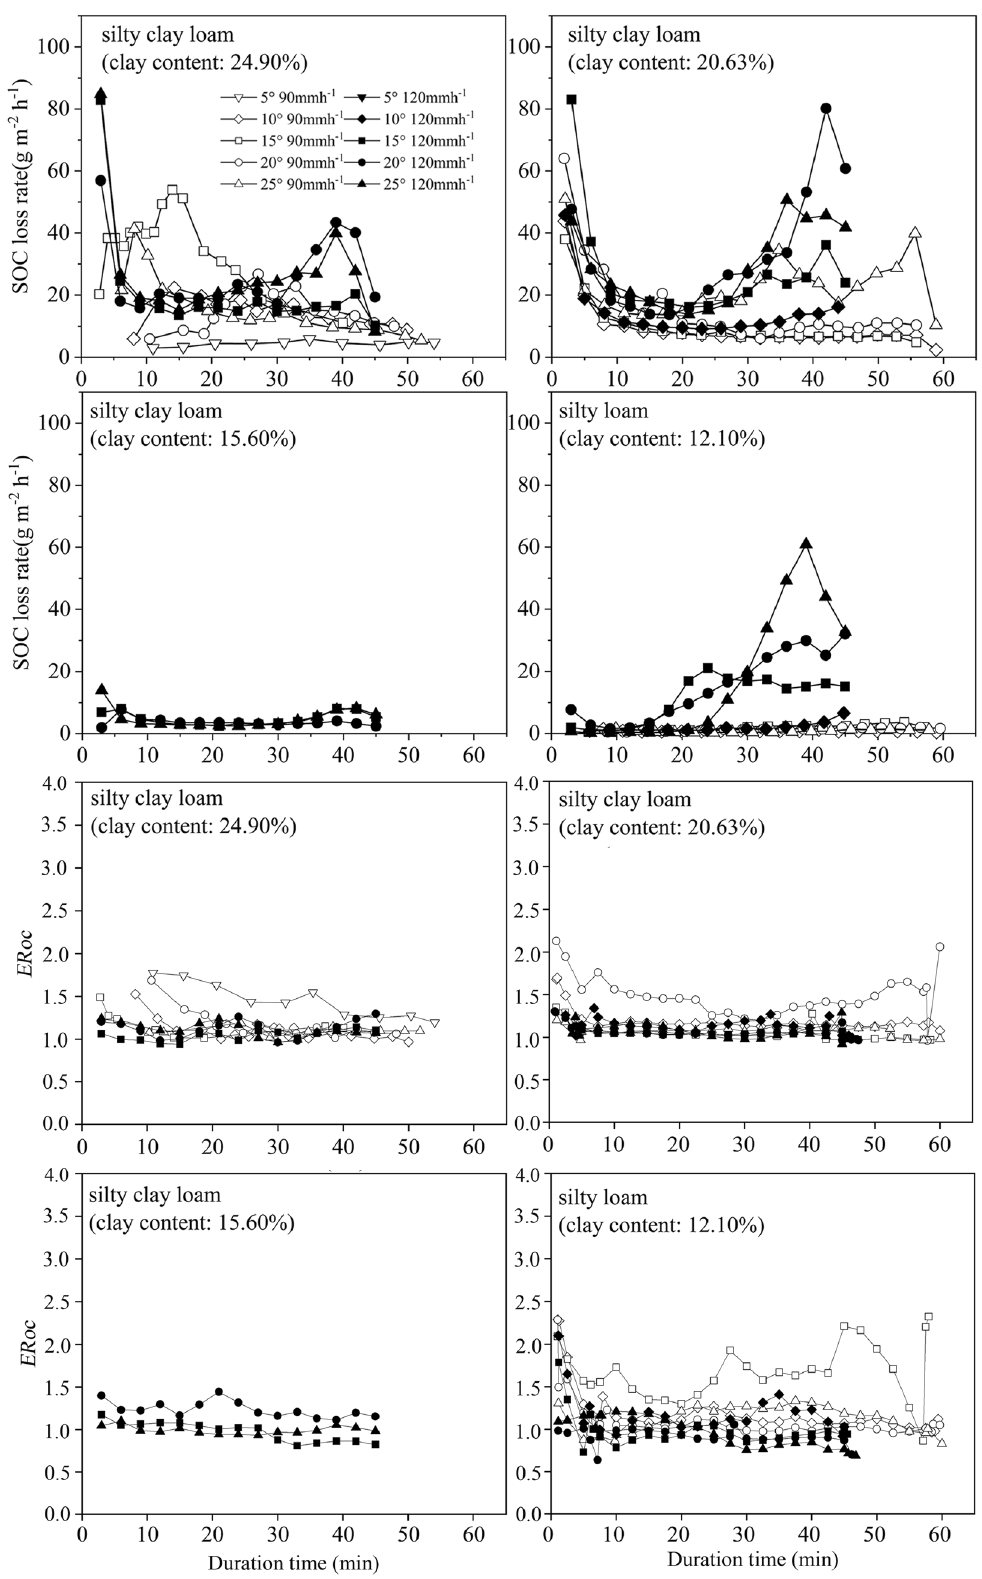
Fig. 6 SOC loss rate and ERoc for loess under different rainfall intensity and